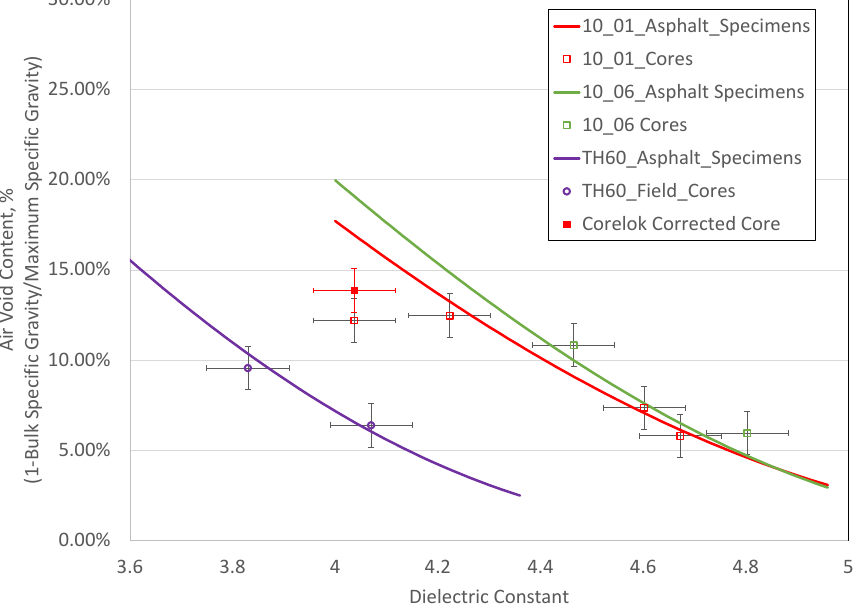
Figure 19. Each production day asphalt specimen generated dielectric to air void content models and corresponding field dielectric and core validation values.